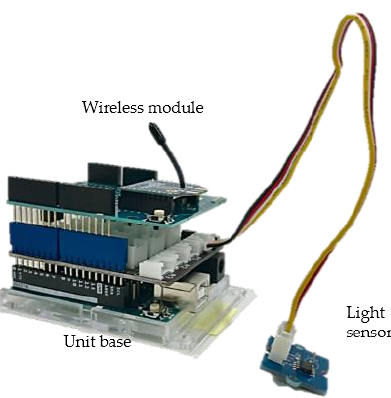
Figure 6. A light sensor unit body with a wireless module attached.